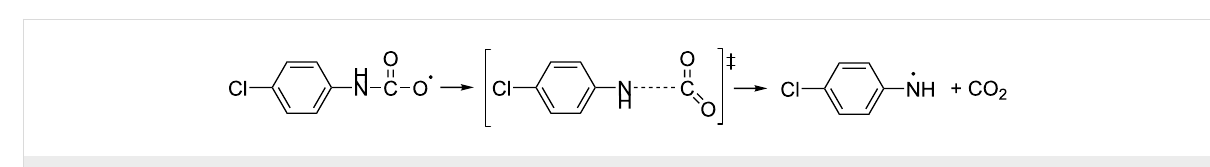
Scheme 3: Decarboxylation reaction of the p -chlorophenylcarbamoyloxyl